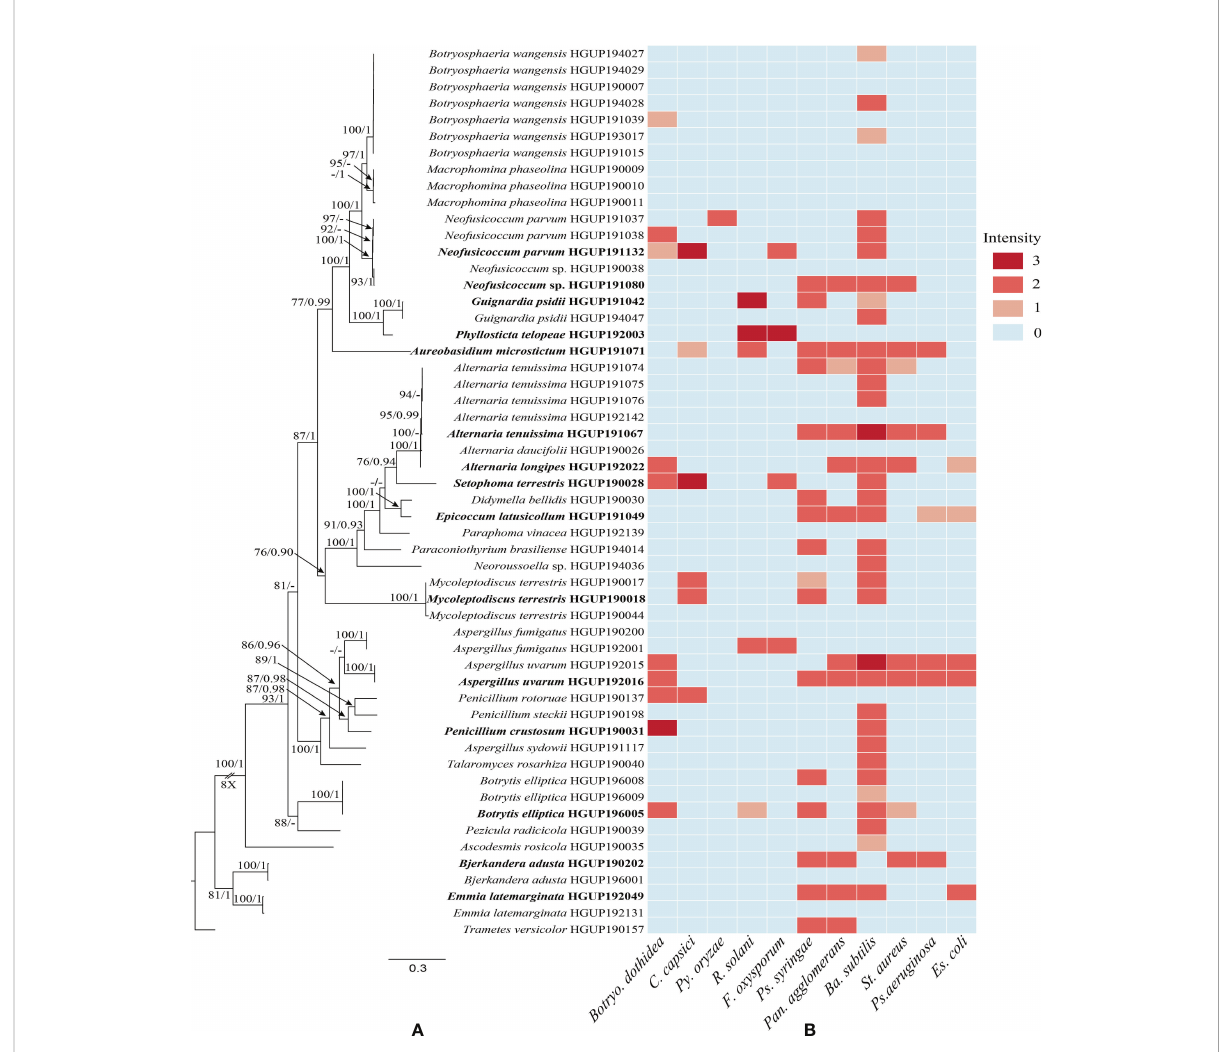
FIGURE 1 Phylogenetic relationships and preliminary screening for antimicrobial activity of endophytic fungi. (A) Phylogram generated from maximum likelihood (ML) analyses, based on combined ITS, LSU, TUB, and RPB2 sequence data. Bootstrap support values for ML greater than 75% and Bayesian posterior probabilities greater than 0.90 are given near nodes, respectively. Bold indicates strains that have been preliminarily screened out. (B) Heatmap of antimicrobial activity spectra against the tested